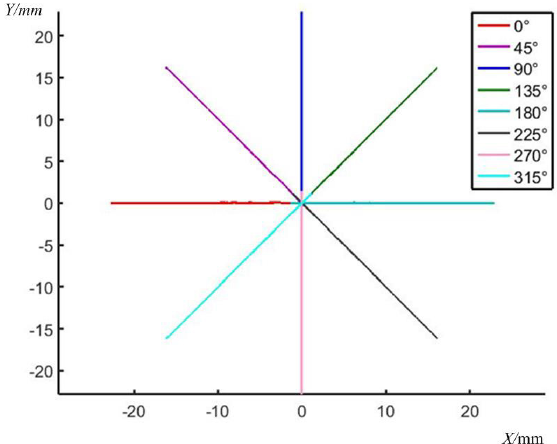
Figure 29. Eight displacement trajectories of the